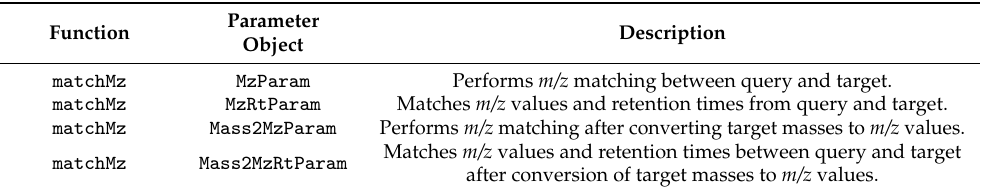
Table 2. High-level functions to perform MS 1 annotation. The algorithm used by matchMz can be selected and configured with a parameter object. Supported input objects are at present numeric , data.frame , SummarizedExperiment , CompDb and IonDb .